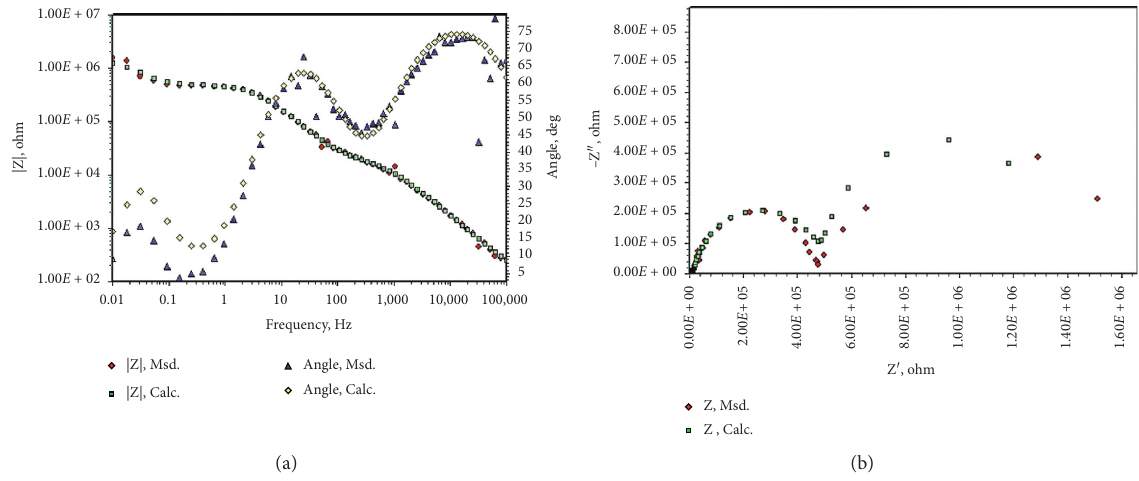
Figure 6: (a) Bode and (b) Nyquist curves of MAO coating after being immersed in 3.5 wt.% NaCl solution for 1 day.